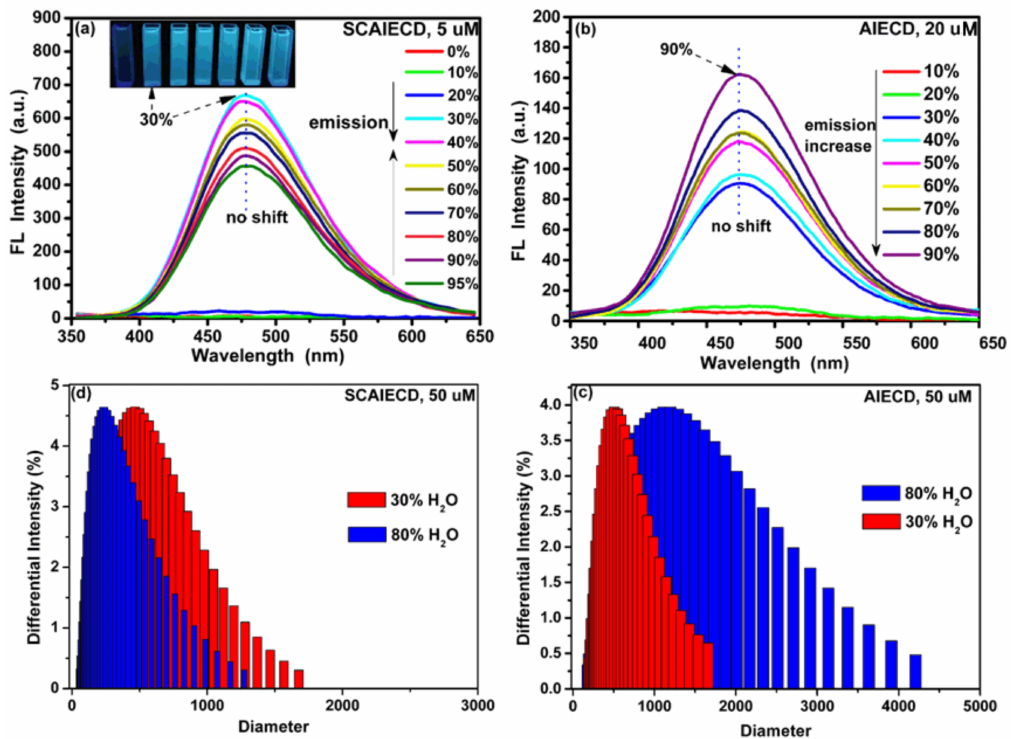
Figure 2. ( a ) Fluorescence emission spectra for solutions of SCAIECD (5 µ M) in different ratios of DMSO/H 2 O ( v / v ); ( b ) fluorescence emission spectra for solutions of AIECD (20 µ M) in different ratios of DMSO/H 2 O ( v / v ); ( c ) DLS results of SCAIECD (5 µ M) in DMSO/H 2 O ( v / v ); and ( d ) DLS results of AIECD (50 µ M) in DMSO/H 2 O ( v / v